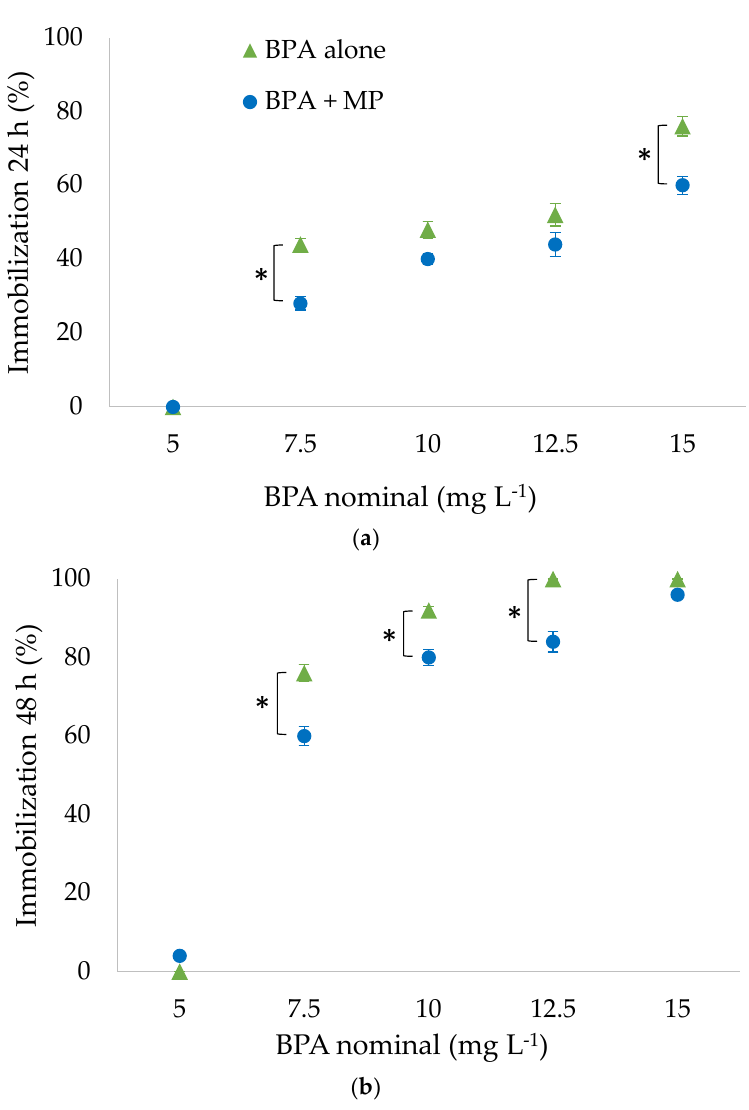
Figure 1. Immobilization of daphnids after ( a ) 24 h; and ( b ) 48 h of exposure with bisphenol A (BPA) and microplastics (MP), in different treatments with increasing nominal BPA concentrations for BPA alone and BPA in combination with microplastics (BPA + MP; 5 – 15 mg L − 1 ), and one concentration of microplastics for BPA + MP (200 mg L − 1 ; mean ± SE, n = 5). Brackets marked with asterisks indicate significant differences (Fisher’s exact test, p < 0.05) between treatments with BPA alone and BPA + MP. Calculated BPA concentrations in water ( c w , calculated ) are close to measured values ( c w , measured ), confirming accuracy of the measurements and that sorption equilibrium was reached (Figure 2).